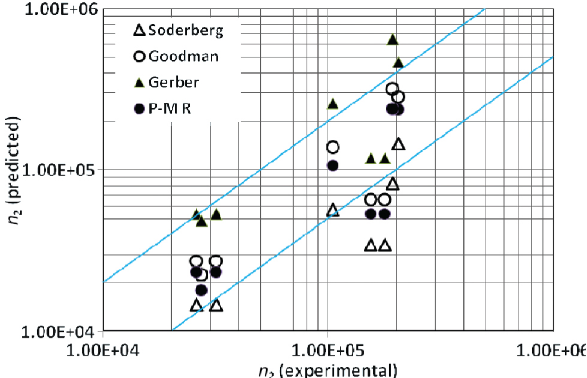
Figure 10: Comparison of different S-N models with the experimental results of 19501 aluminium